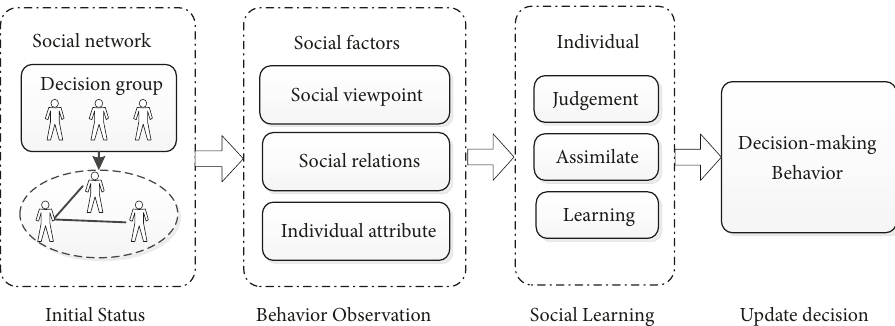
Figure 2: The social learning process of voting groups based on social networks.